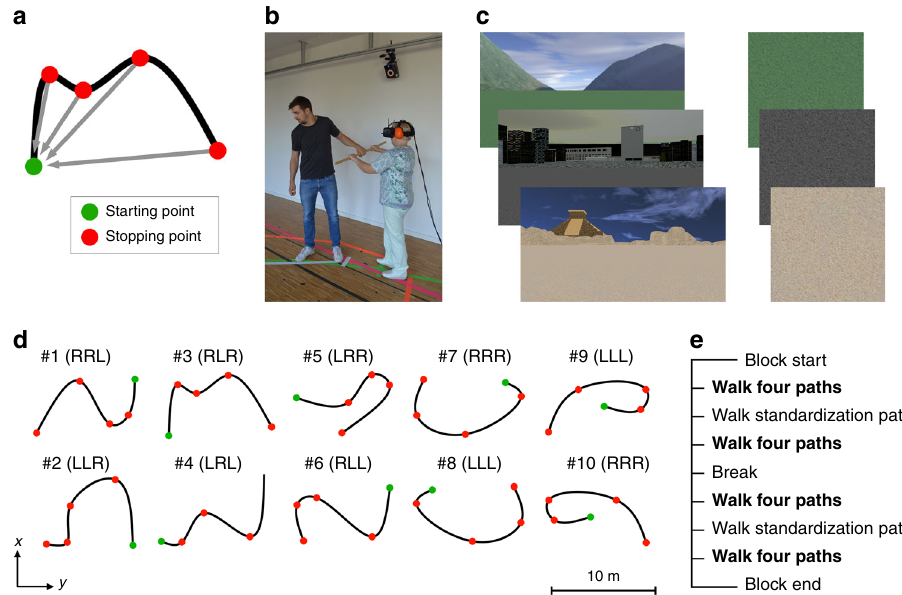
Fig. 1 Path integration task. a Example path from top-down perspective. Participants began at the starting point (green dot) and then walked along the path (curved black line). There were four stopping points (red dots) along each path; at these points, participants were asked to report their estimate of the direct distance and angle to the path ’ s starting point. b During the experiment, participants saw a virtual environment from fi rst-person perspective via a head- mounted display (HMD). Movements in the real world were tracked with a motion tracking system and translated to movements (i.e., changes in location and viewing orientation) in the virtual environment. Participants held a wooden stick and were guided by the experimenter along a path. At each stopping point, the direct distance to the starting point had to be estimated verbally in meters and centimeters, and participants turned their body on the spot to indicate the orientation to the starting point. c Three different virtual environments (left panel) used in the path integration task. Each environment comprised a ground plane and distant landmark cues. Landmark cues were rendered at in fi nity, in order to allow participants to determine their heading direction, but not position or distance information. One tile of each environment's ground plane is shown in the right panel. These tiles were textured to provide optic fl ow during movement, but were seamless (no visible border between adjacent tiles) and provided no fi xed cues with positional information. d Overview of the 10 different paths used in the experiment. Each path contained three turns, and turn directions (i.e., left “ L ” and right “ R ” turns) were counter-balanced between paths. e Participants performed three blocks of the path integration task. Each block consisted of 16 paths (paths #1 – 10, and paths #1 – 6 repeated without intermediate stopping at stopping points 1 – 3). In addition, after the 4th and 12th path of each block, participants performed so-called “ standardization-paths ” (i.e., straight lines with a length of 2, 6, and 10m), which were used to correct for each participant ’ s bias in converting their internal location estimate to a verbal response. Text in bold in panel e indicates the phases used for data analyses. See “ Methods ” section for more